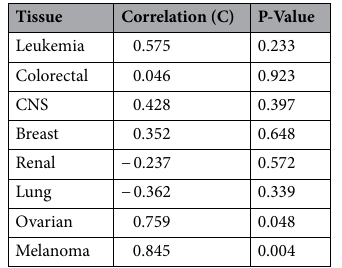
Table 3. Table of cell lines used for cell line specific